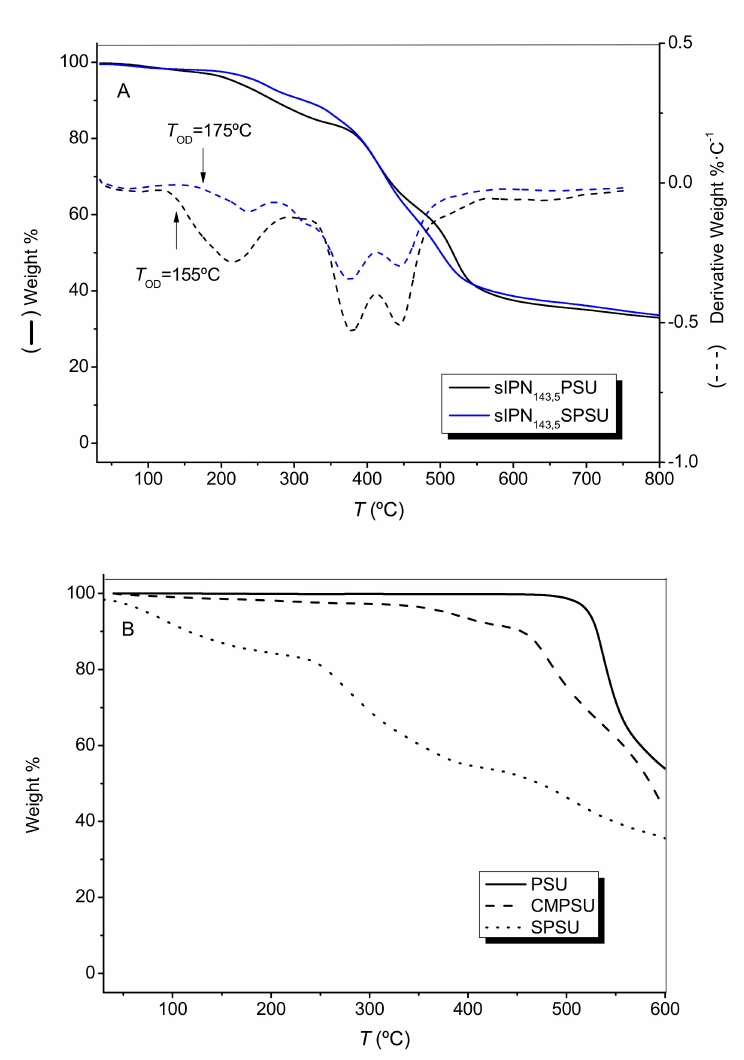
Figure 4. ( A ) Thermogravimetric curves of sIPN 143,5 -PSU and sIPN 143,5 -SPSU under nitrogen atmo- sphere. Weight % and derivative weight of the membranes. ( B ) Thermogravimetric analysis (TGA) curves of PSU, CMPSU and SPSU under air